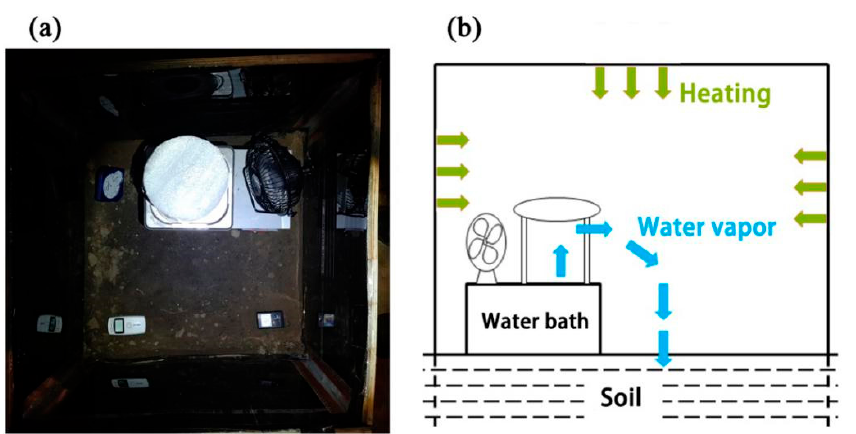
Figure 4. A photograph of the experimental setup (( a ), top view, top board removed) and a schematic (( b ), side view) [16]. Water will condense on the soil surface where the temperature was below dew point.